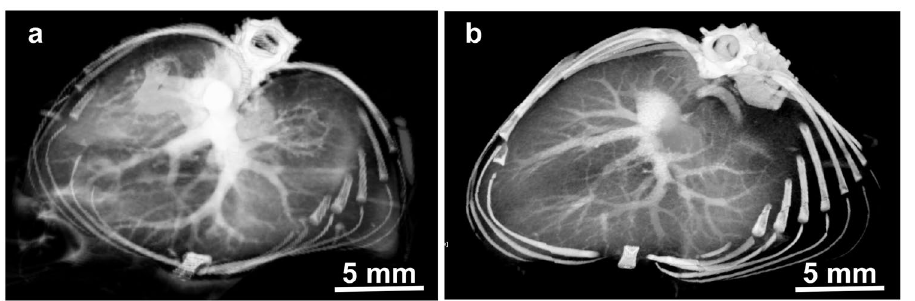
Figure 5. MicroCT axial views of liver region at 2 min ( a ) and 30 min ( b ) after IV injection of INPs (1.75 g